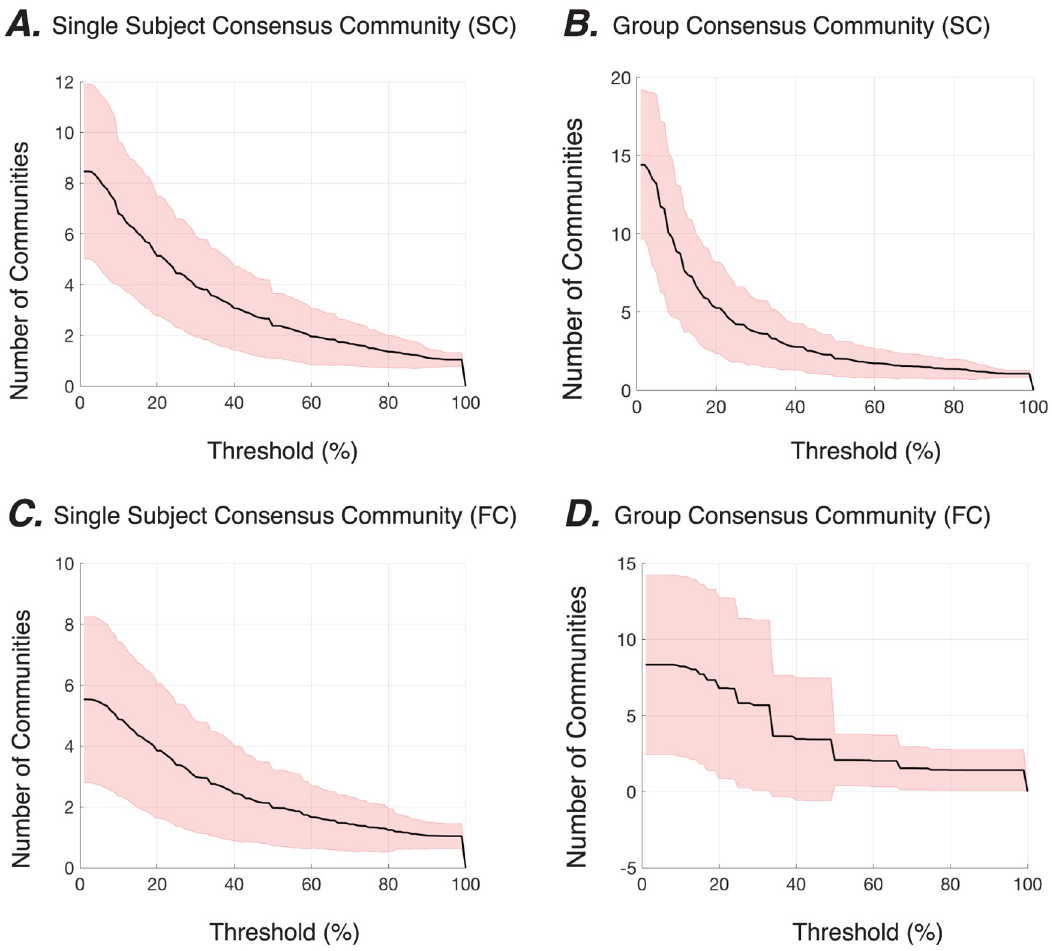
Fig 5. Local topological scales of hierarchical community organization in structural and functional brain graphs. The black lines show the average number of communities to which each node is allied across different stability thresholds in the hierarchical community organization of SC (A-B) and FC (C-D) graphs, at both the subject level (A,C) and the group level (B,D) . Shaded areas show standard deviation. We define the stability threshold as the percent range of γ values over which a node is stably allied to a given community, here shown along the x